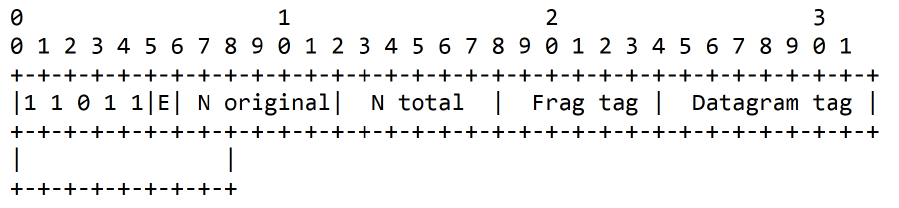
Figure 11. Structure of the 6LoWPAN fragment header with NCFEC.